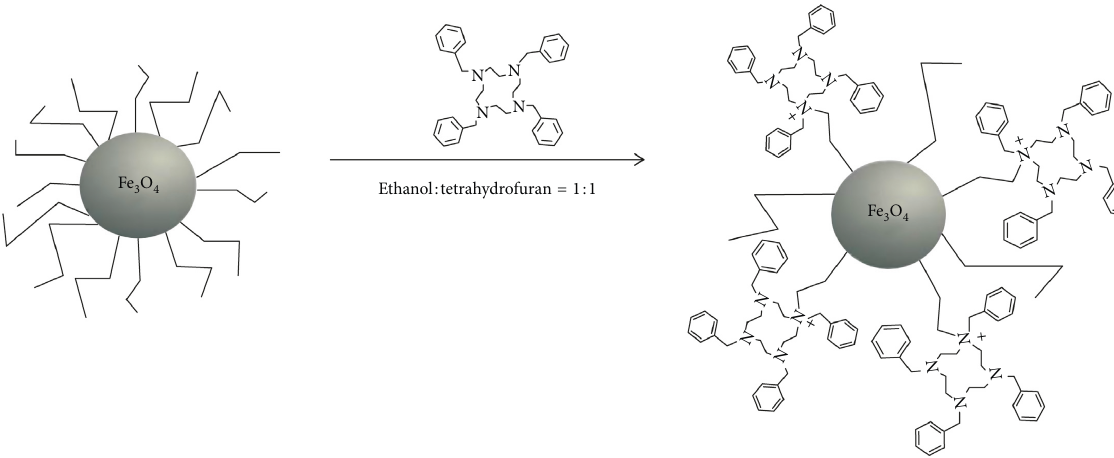
3 O 4 /TBCD MNP [71].